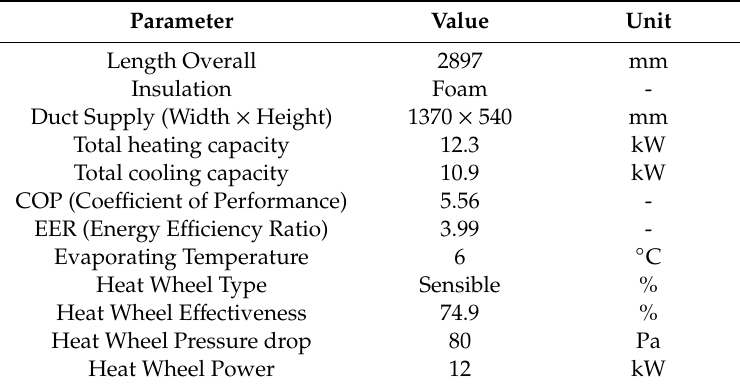
Figure 3. The AHU schematic in the building management system (BMS). 3. Description of the Used Mathematical Model In this study, the performance of the air handling unit was investigated by calculating the cooling/heating capacity of the direct expansion coil, electrical power input of the VRV, coefficient of